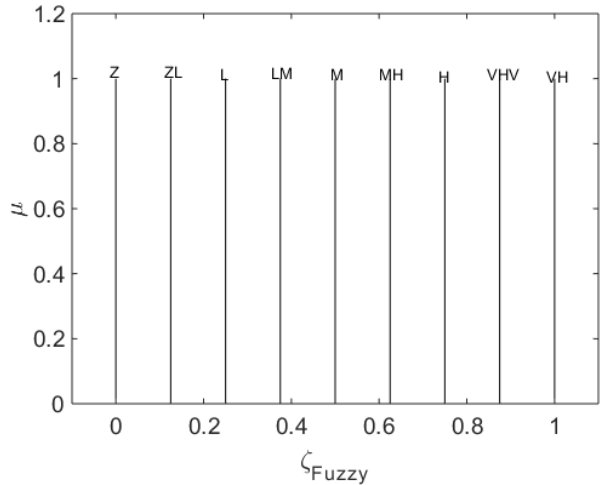
Figure 3. Output membership functions of the fuzzy